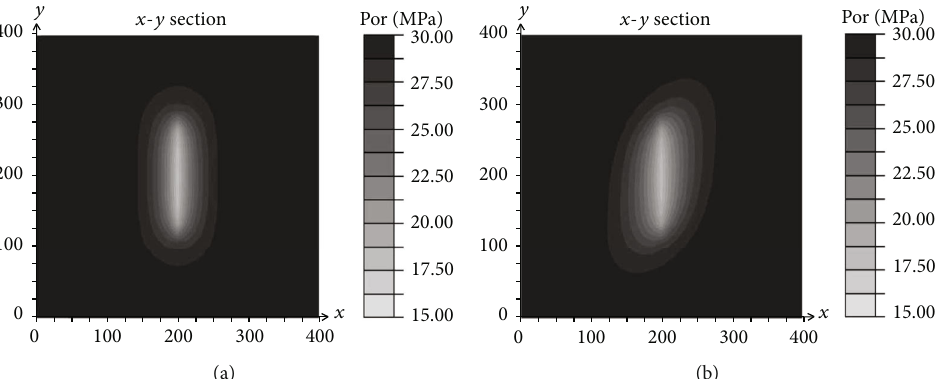
Figure 5: Panels (a) and (b), respectively, represent the pore pressure distribution without the in fl uence of the natural fractures and the pore pressure under the in fl uence of the natural fractures.